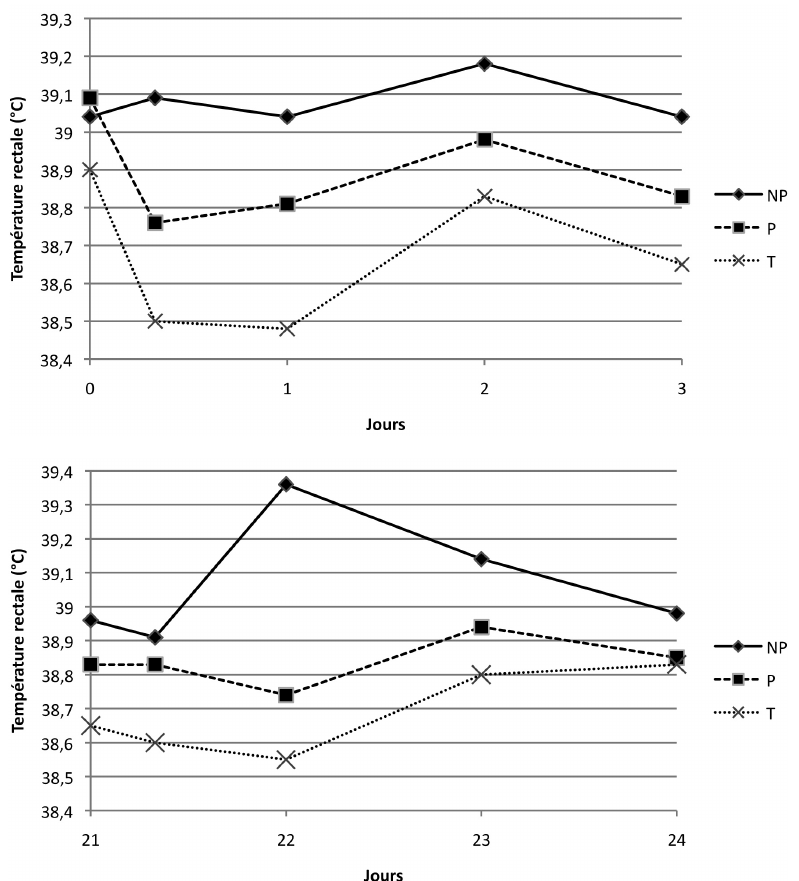
Figure 1. – Moyenne des tempéra- tures rectales (°C) suite à la primo- immunisation des groupes NP, P, et T.